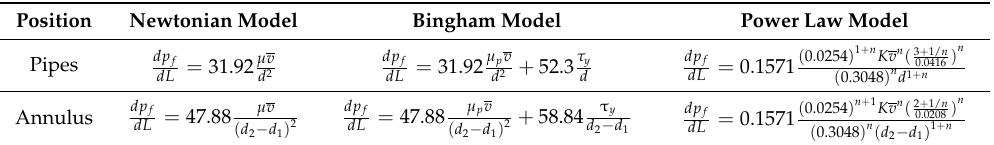
Table 2. The frictional pressure loss of a different rheological model under laminar in the pipe and annulus